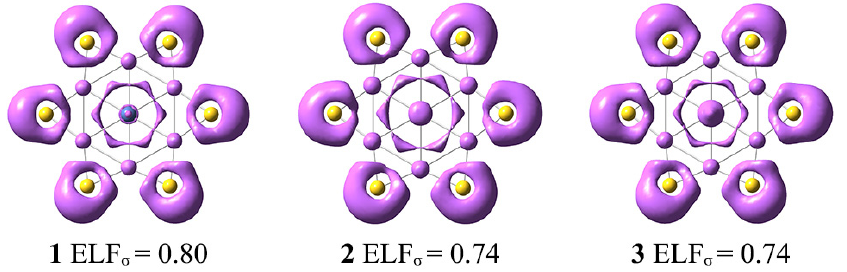
Figure 6. Electron localization function (ELF) of σ electron clouds for 1 – 3 . The approximated bifur- cation values are shown.